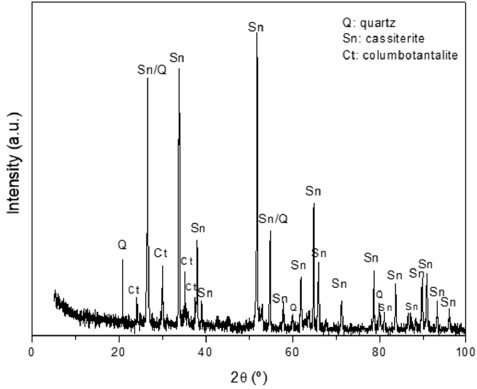
Figure 3. X-ray diffraction analysis (XRD) patterns of the mineral concentrate.